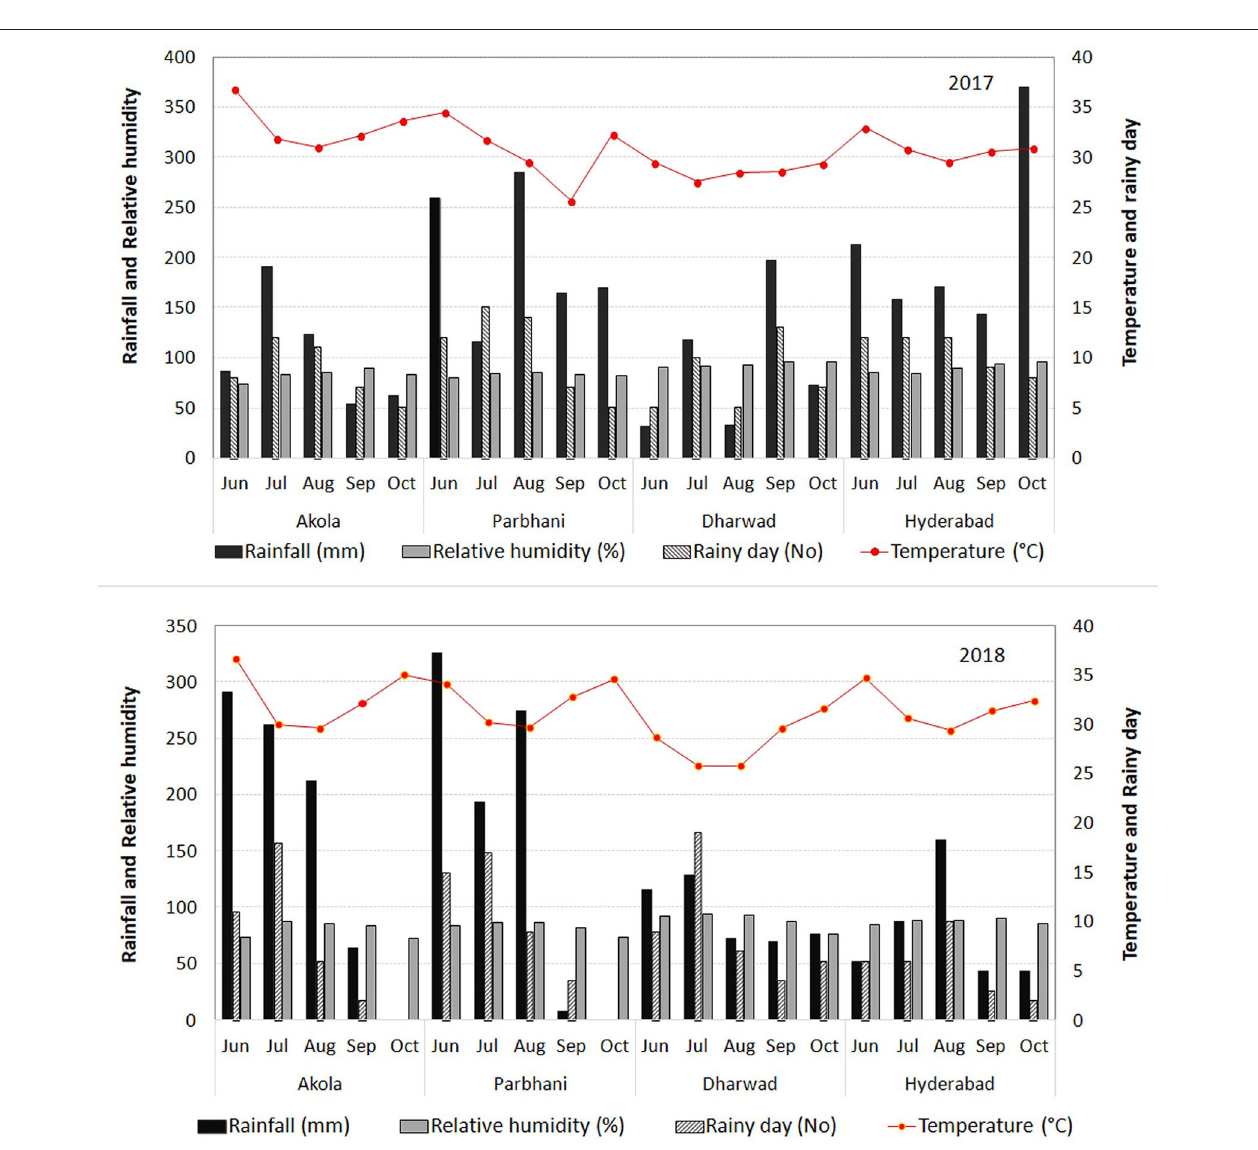
FIGURE 1 | Meteorological data [rainfall, the number of rainy days, relative humidity (RH), and temperature] in the four locations of the study during 2017 and 2018.